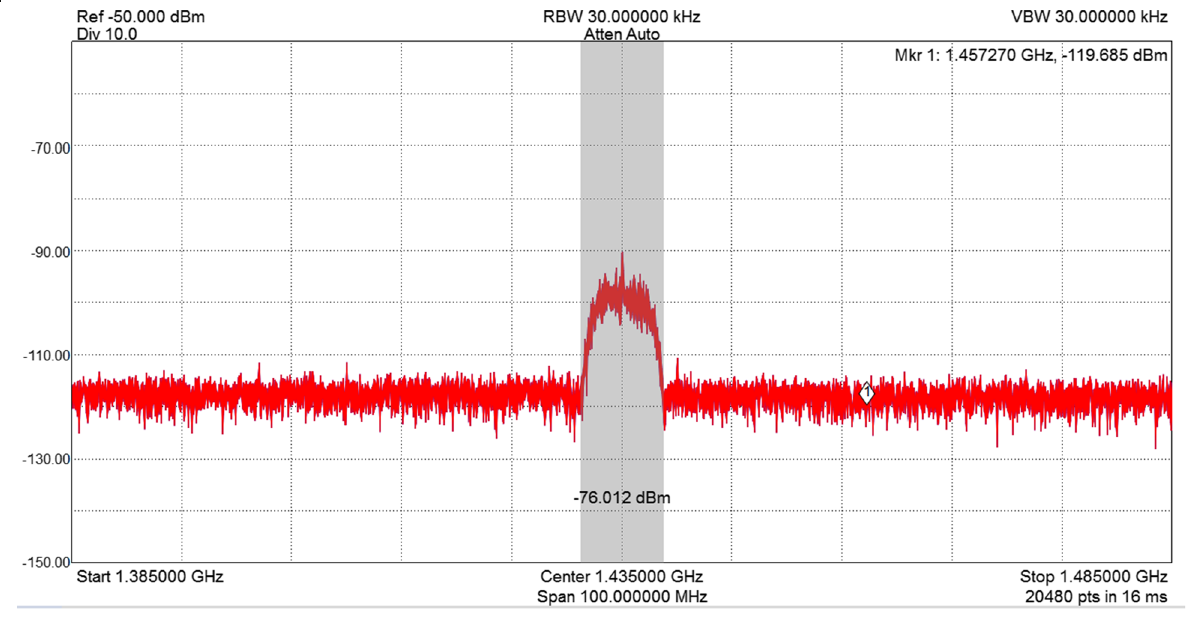
Fig. 17 The frequency spectra at the receiving terminal. AD9361 is set as the working modes of 1R1T, LVDS, and TDD. The ADC frequency is set as 13 MHz, and the local frequency is set as